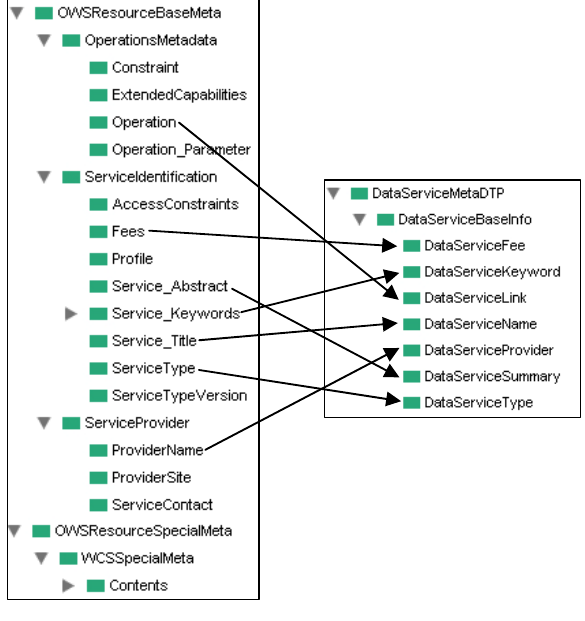
Figure 5. The mapping relations of semantic properties between WCS and general query schema